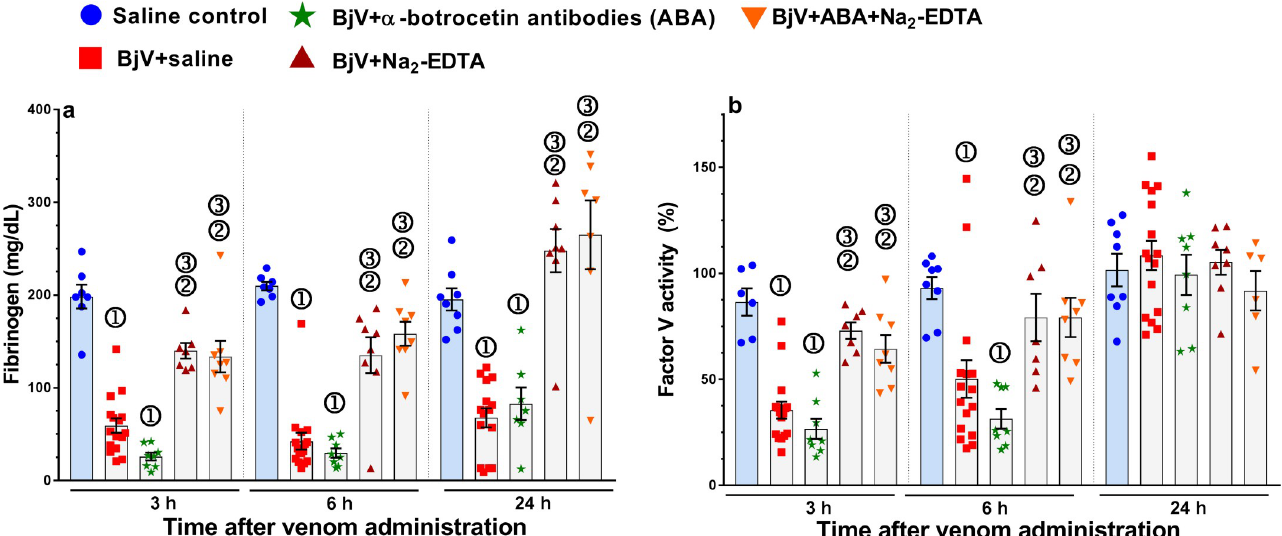
Fig 1. Plasma fibrinogen ( a ) and factor V ( b ) levels in rats 3, 6 and 24 h after BjV administration. Rats were injected with saline alone (saline control, blue bars), or BjV previously incubated with saline (BjV+saline), anti-botrocetin antibodies (ABA), BjV+Na 2 -EDTA, or BjV+ABA+Na 2 -EDTA. ① —Group statistically different (p < 0.05) from the saline control group at the respective time. ② - Group statistically different (p < 0.05) from the BjV+saline group at the respective time. ③ —Group statistically different (p < 0.05) from the BjV+ABA group at the respective time. Data are expressed as mean ± s.e.m (n = 6–16 rats/group per time period).